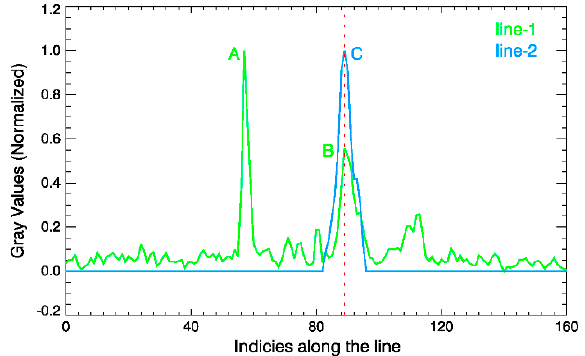
Figure 4. The normalized gray values vs. pixels along the lines in Figure 3D (green) and Figure 3F (blue). The red dotted line represents the boundary along the line.